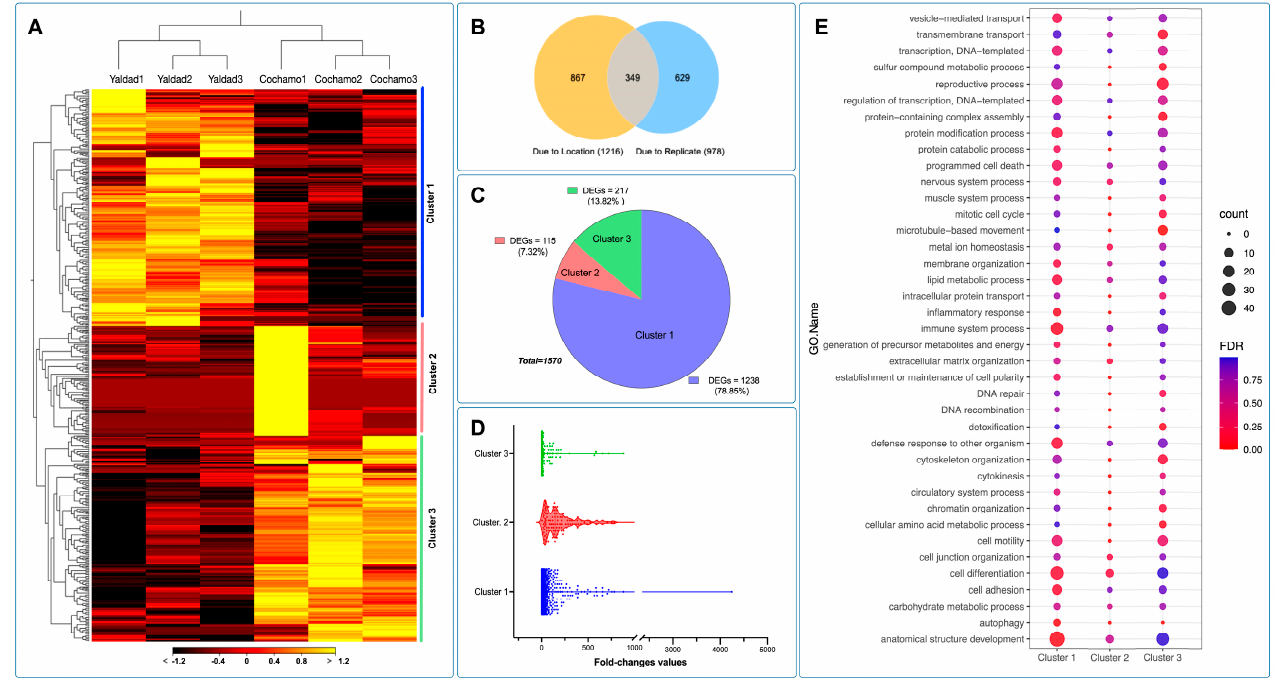
Figure 6. Population-speci fi c transcriptome analysis in the blue mussel M. chilensis . ( A ) Transcriptome pa tt erns of coding genes analyzed in gills from Yaldad and Cochamó populations. Three replicates were evaluated from each experimental group. The heatmap was based on transcripts per million (TPM) calculation and hierarchical clustering on Manha tt an distances with average linkage (fold change ≥ |4|; FDR = 0.05). Yellow colors mean upregulated coding genes and black represents downregulated genes. ( B ) Venn diagram showing shared and unique genes expressed among the locations and replicates. ( C ) Pie chart showing the number of di ff erentially expressed genes (DEGs) annotated for expression clusters 1, 2, and 3 between the Yaldad and Cochamó populations. ( D ) Fold-change values observed for DEGs identi fi ed in each evaluated cluster. ( E ) GO enrichment of cluster-speci fi c genes ( p -value < 10–16; |fold-change| > 4) annotated for key biological processes di ff erentially expressed. The y -axis indicates the GO term, and the x -axis indicates the clusters identi fi ed in ( A ). The color bar indicates the enrichment analysis estimated by FDR (false discovery rate) < 0.05 for the DEGs (fold change > 4, p < 0.01). The bubble size indicates the number of genes asso-